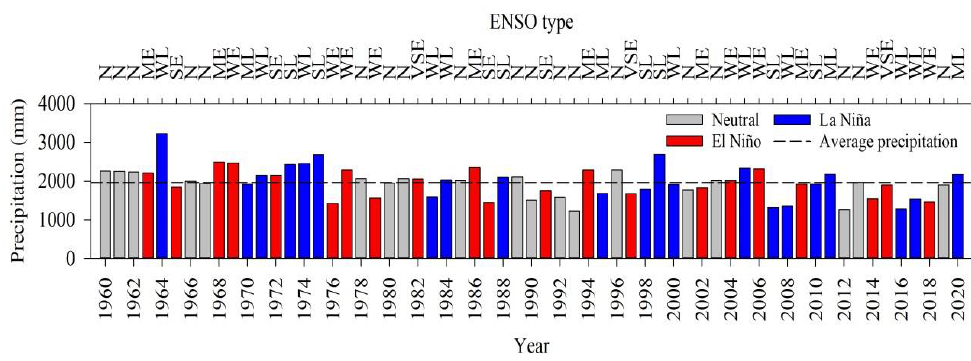
Figure 4. Annual rainfall distribution (mm/year) in the SNEB capital — Salvador. El Niño, La Niña, Neutral, and their intensities based on the Oceanic Niño Index (ONI): N: Neutral, WE: weak El Niño; ME: moderate El Niño; SE: strong El Niño; VSE: very strong El Niño; WL: weak La Niña; ML: moderate La Niña; and SL: strong La Niña. The colors in the bars are Neutral in grey, La Niña in blue, and El Niño in red, and the dashed line represents average rainfall for the period 1960 – 2020.